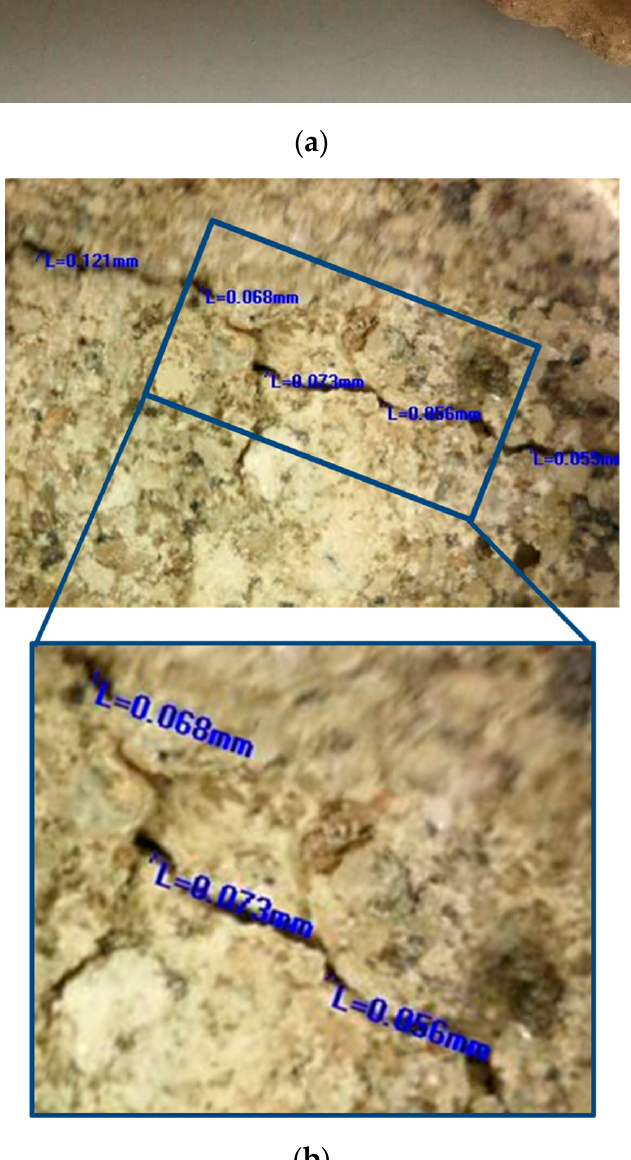
Figure 1. Original mortar: ( a ) photo of the sampled materials; ( b ) example of microscopic images of the cracks in original walls (measured crack width: 0.121 mm; 0.068 mm; 0.073 mm; 0.056 mm; 0.059 mm; average 0.075 mm).